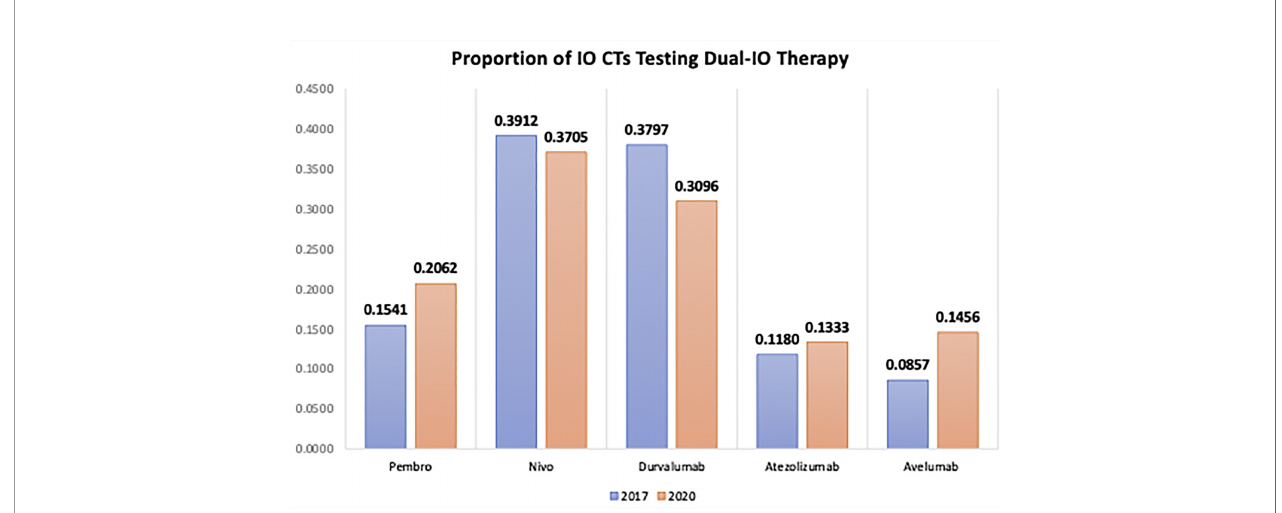
FIGURE 4 | Percentage of ICI Agents Studied in Combination as a Proportion of the Total Trials Per Agent. The percentage of current RCTs that are studying the following ICI agents in combination strategies organized by ICI class. IO, Immuno-Oncologic Therapy; RCT, Randomized Control Trial; ICI, Immune-checkpoint Inhibitor; Pembro, pembrolizumab; Nivo,